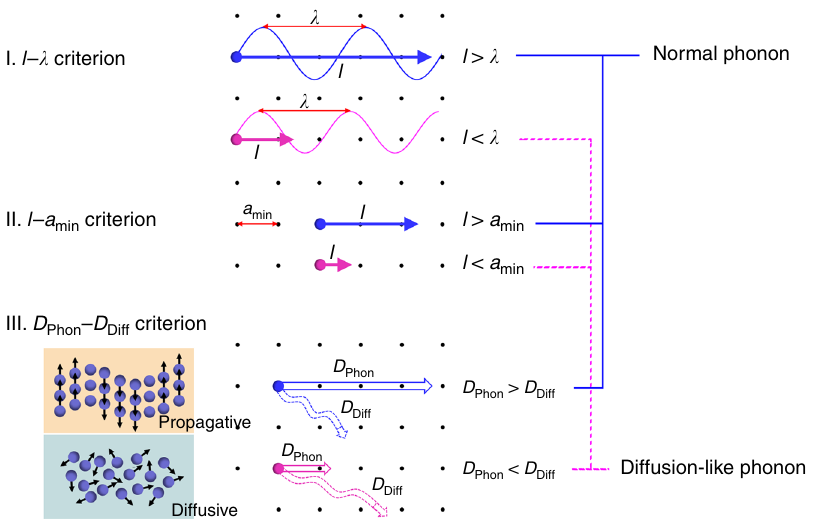
Fig. 2 Dual-phonon judging criteria for vibrational modes. Three different criteria are proposed for the assignment of each vibrational mode to be a normal phonon or a diffuson-like phonon. The visual representation of the diffusive/propagative transport is drawn in analogy with Agne et al. ’ s work 10